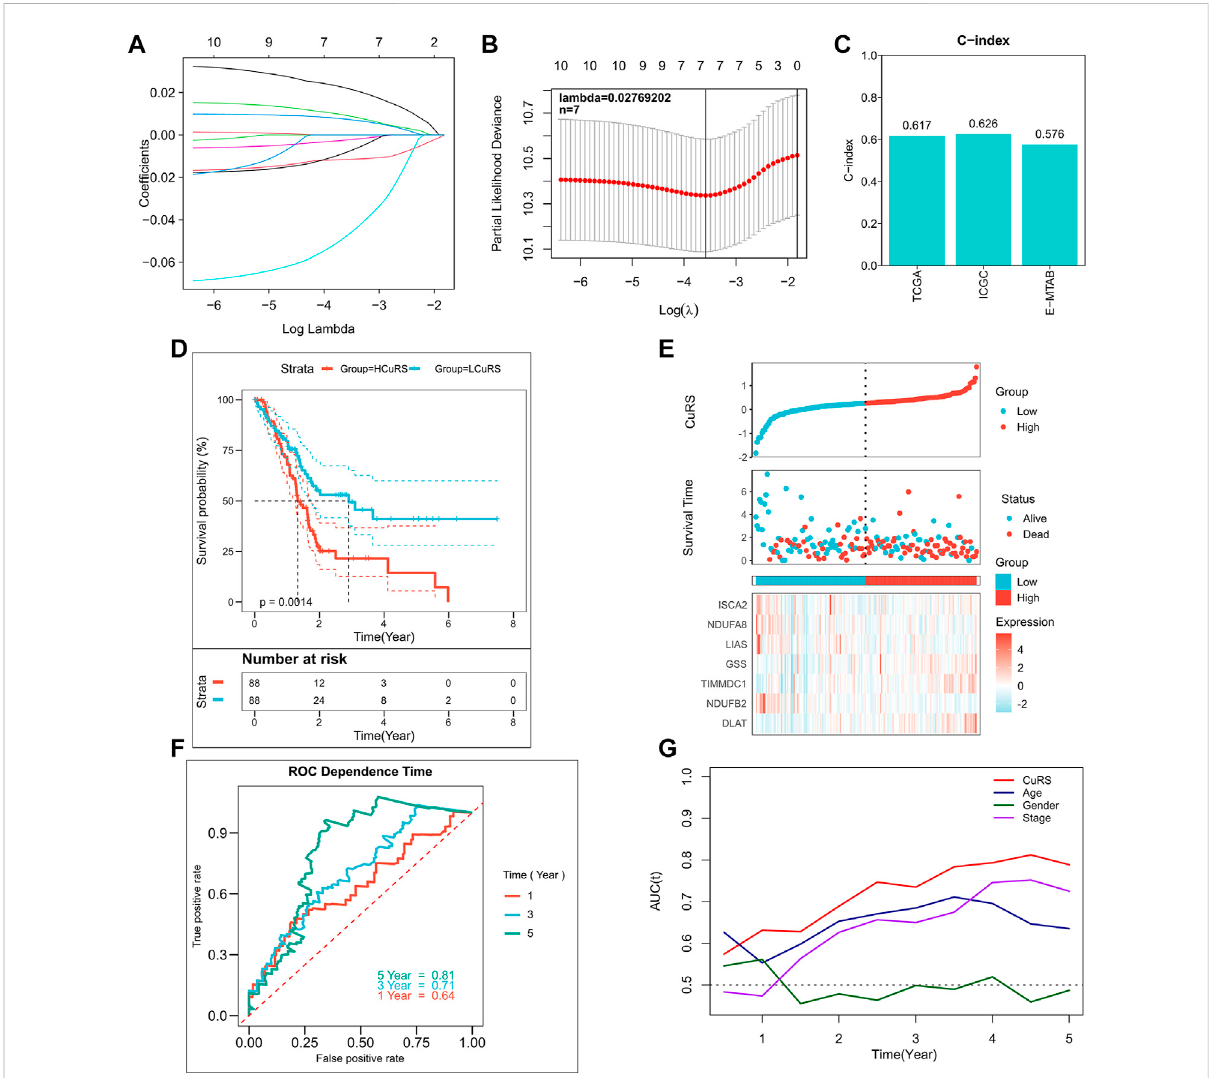
FIGURE 2 Construction of the CRG-based risk model. (A) Construction of the LASSO model; (B) Construction of the optimized model incorporating 7CRGs based on theoptimal lambda; (C) C-index of theoptimized modelin TCGA, ICGC,and E-MTAB cohorts; (D) KMsurvival curves for high- and low-CuRS groups in TCGA cohort; (E) Survival status of patients in TCGA cohort and expression of the model genes; (F) 1-, 3-, 5-, and 8-year ROC curves for CuRS in TCGA cohort; (G) CuRS model and tROC curves of clinical characteristics in TCGA